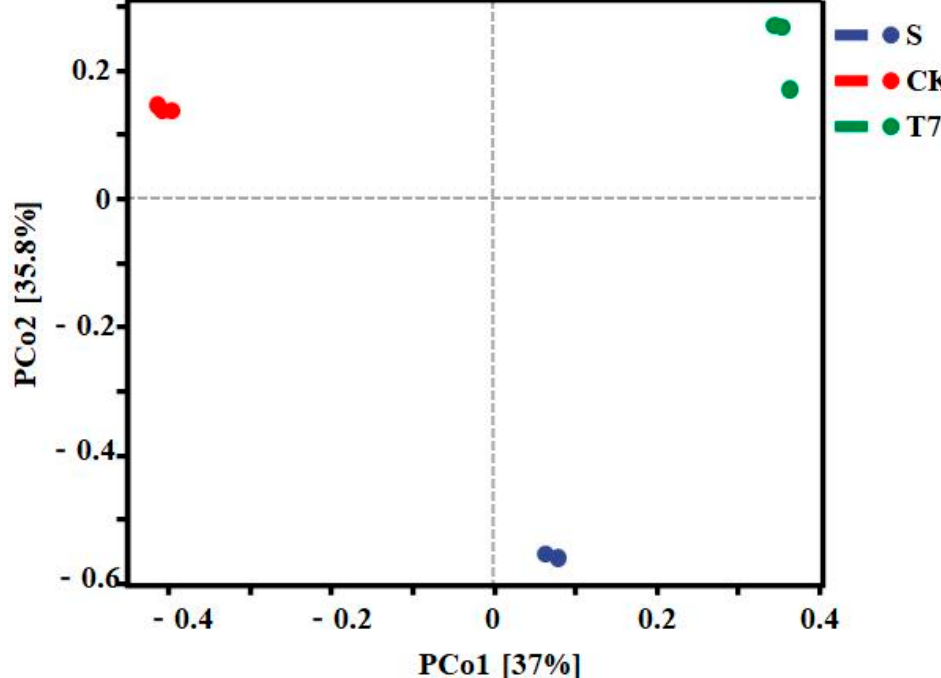
Figure 4. Relative abundance of bacterial communities in soil samples at the genus level. (Unactivated original contaminated soil (S), soil without any additive (CK), BC-nZVI, 10 g/kg (T7)).